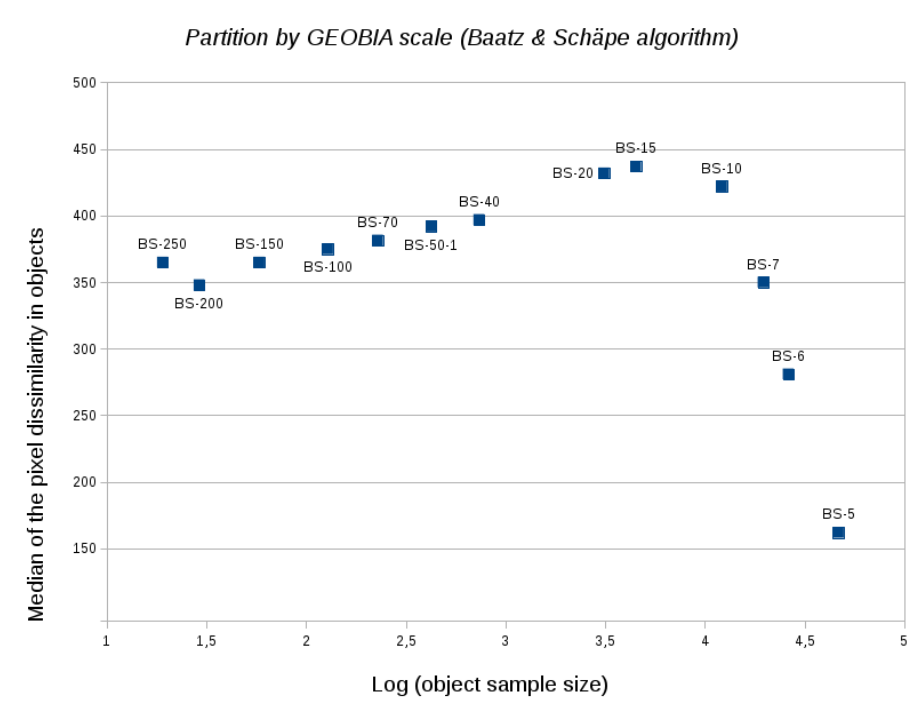
Figure 19. Median of the pixel value dissimilarity in objects with the segmentation based on GEOBIA.